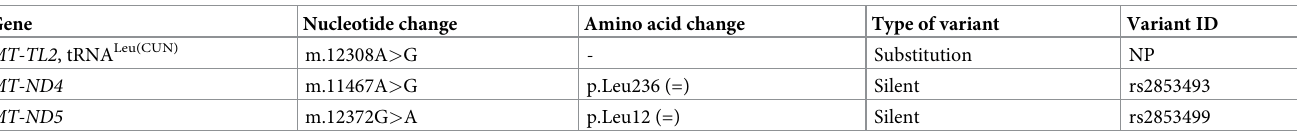
Table 5. mtDNA variants determining haplogroup U in this